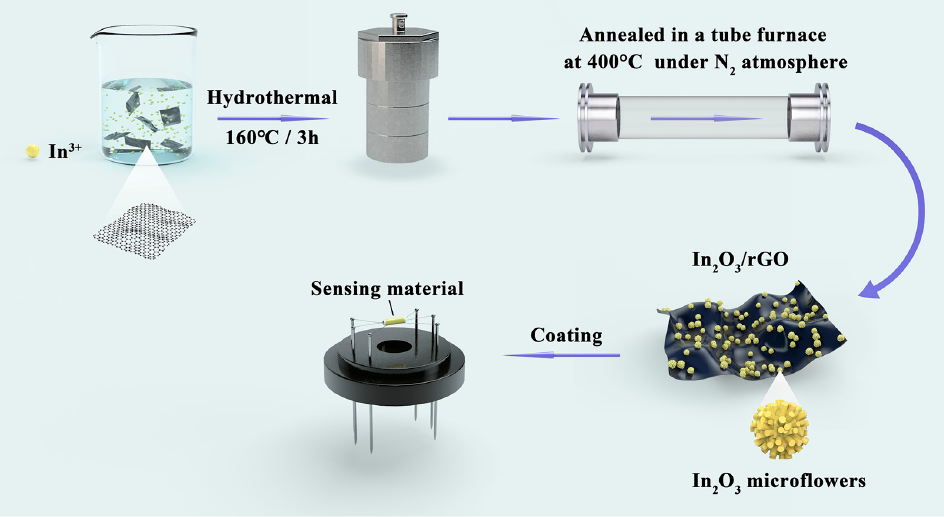
Figure 1. The schematic of the synthesis process of the rGO/In 2 O 3